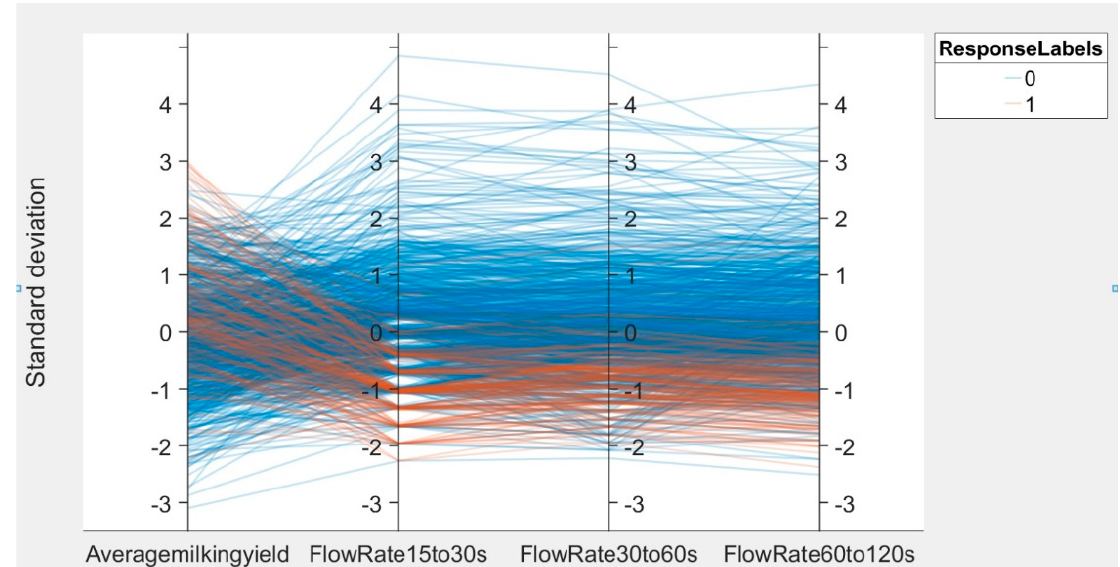
Figure 2. Feature parallel coordinate plot.